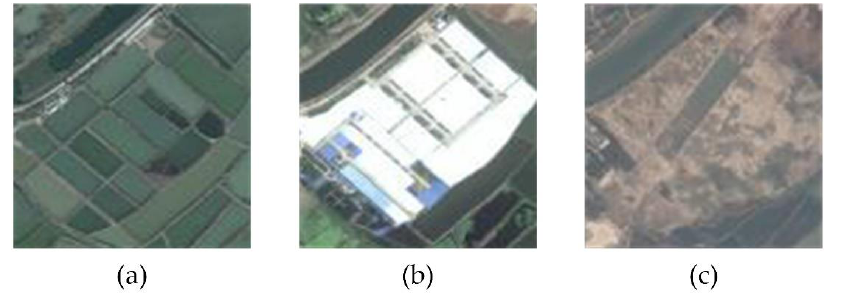
Figure 4. An example of transformation from ( a ) a pervious surface (2006/12/17) to ( b ) an impervious surface (2013/06/13) and ( c ) revision back to a pervious surface (2020/02/25). (1) Detect change points